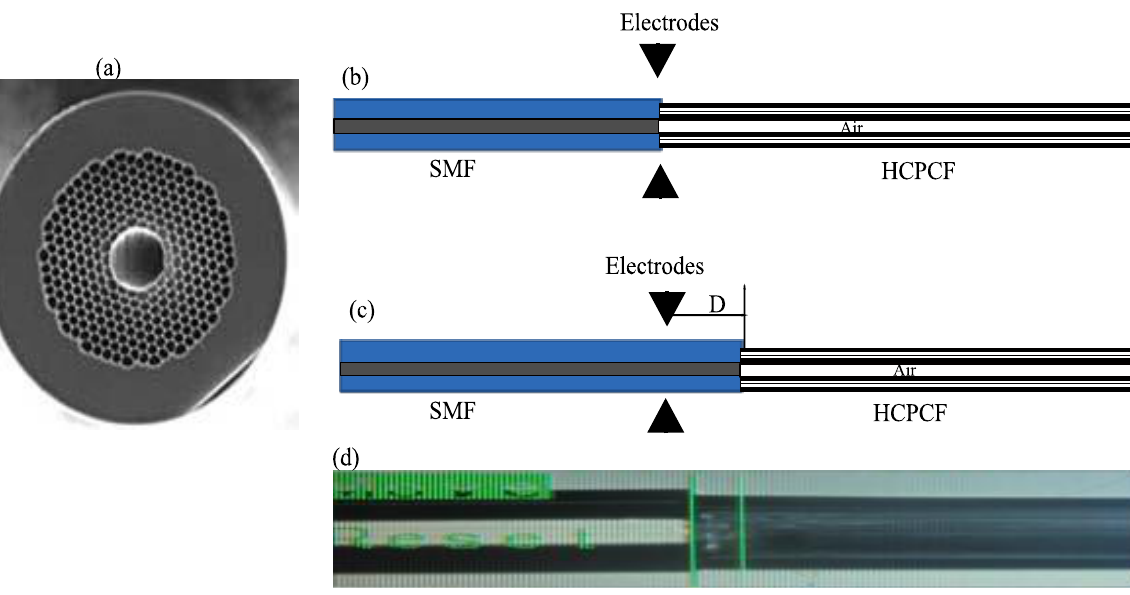
Figure 1. HCPCF-SMF splice joint; ( a ) HCPCF transversal view; ( b ) Initial position at the splicer; ( c ) Offset distance; and ( d ) Exampled of the splice joint obtained.